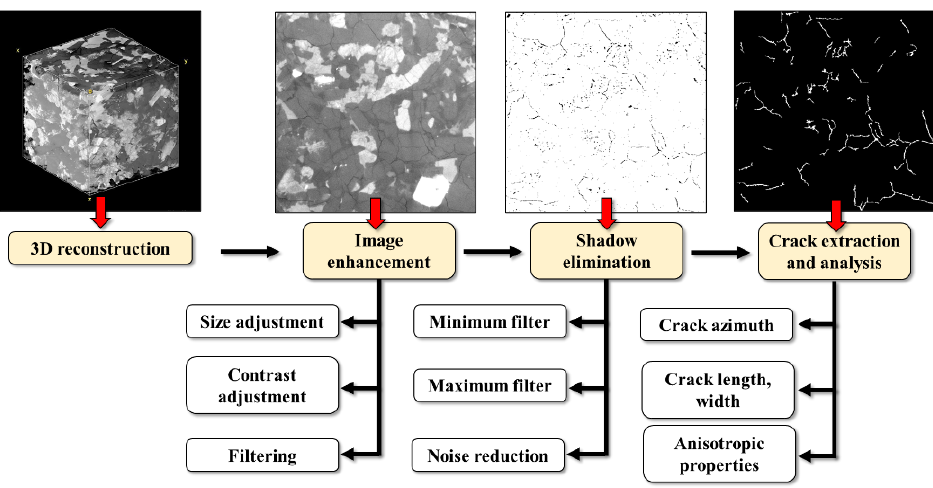
Figure 2. Scheme for the quantitative image processing for CT images.